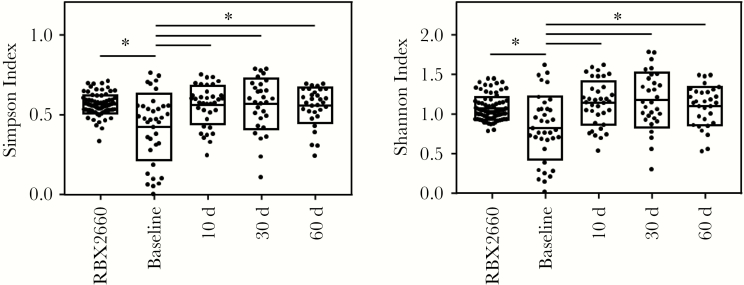
Alpha diversity of RBX2660 and participant samples for each time point group, expressed as the Simpson or Shannon index. Boxes represent group means with standard deviations. *P < . 05 (Wilcoxon test).